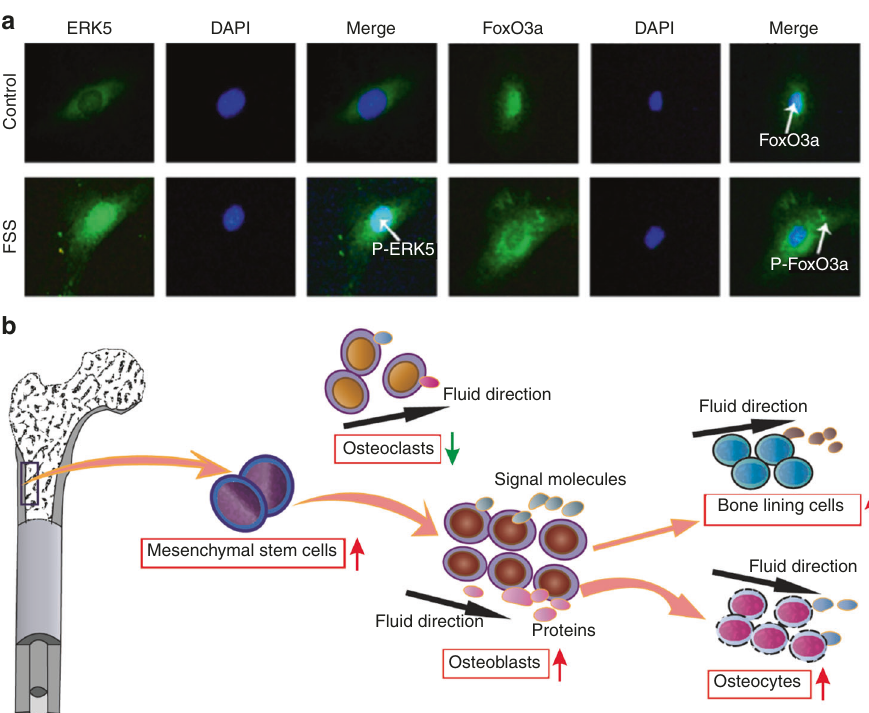
Fig. 10 Effects of FSS on cell differentiation and gene expression. a FSS can affect the signal expression in MC3T3-E1 cells. The nuclear translocation of P-ERK5 and FoxO3a; FoxO3a nuclear translocation (green fl uorescence) and nuclear location (blue fl uorescence) 132 . b Mechanism of FSS on mineralization-related cells. FSS can promote mesenchymal stem cell differentiation into osteoblasts and then promote the further differentiation and orientation of osteoblasts, bone lining cells and osteocytes. More, it can induce the expression of signaling molecules and proteins. Figures adapted with permission from ref.